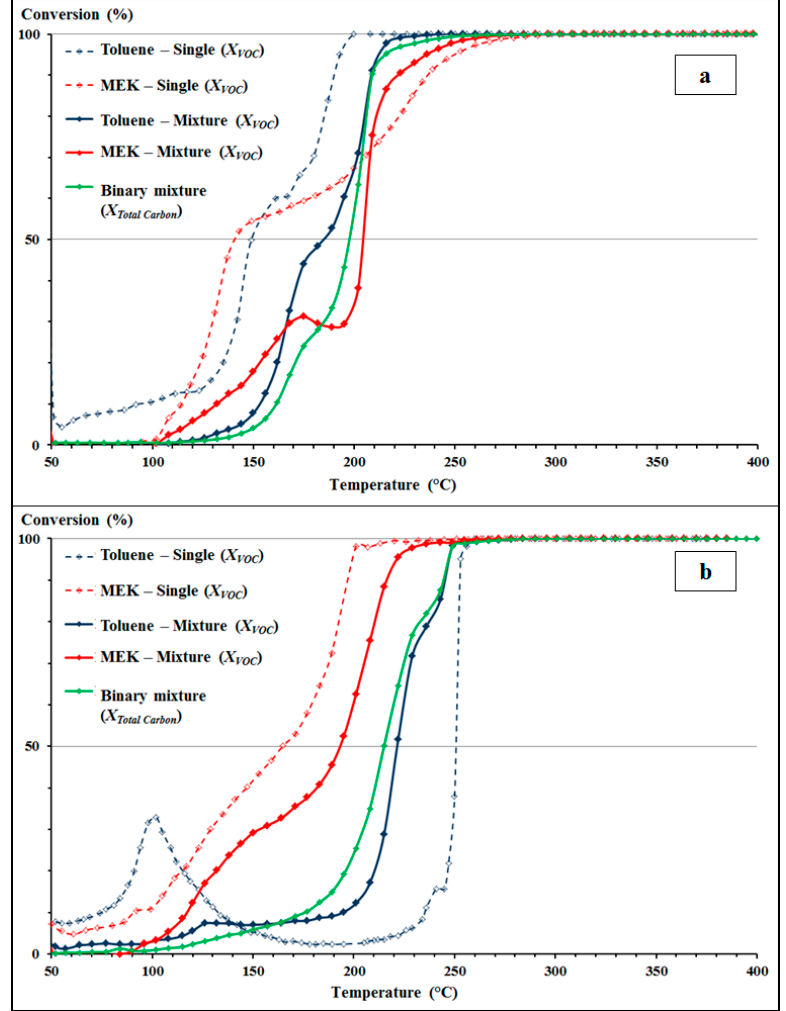
Figure 5. Light ‐ off curves of VOCs alone and in mixture ( X VOC formula) and binary mixture ( X Total Carbon Figure 5. Light-off curves of VOCs alone and in mixture ( X VOC formula) and binary mixture formula) for ( a ) Pd/ γ‐ Al 2 O 3 and ( b ) CoAlCeO catalysts. ( X Total Carbon formula) for ( a ) Pd/ γ -Al 2 O 3 and ( b ) CoAlCeO